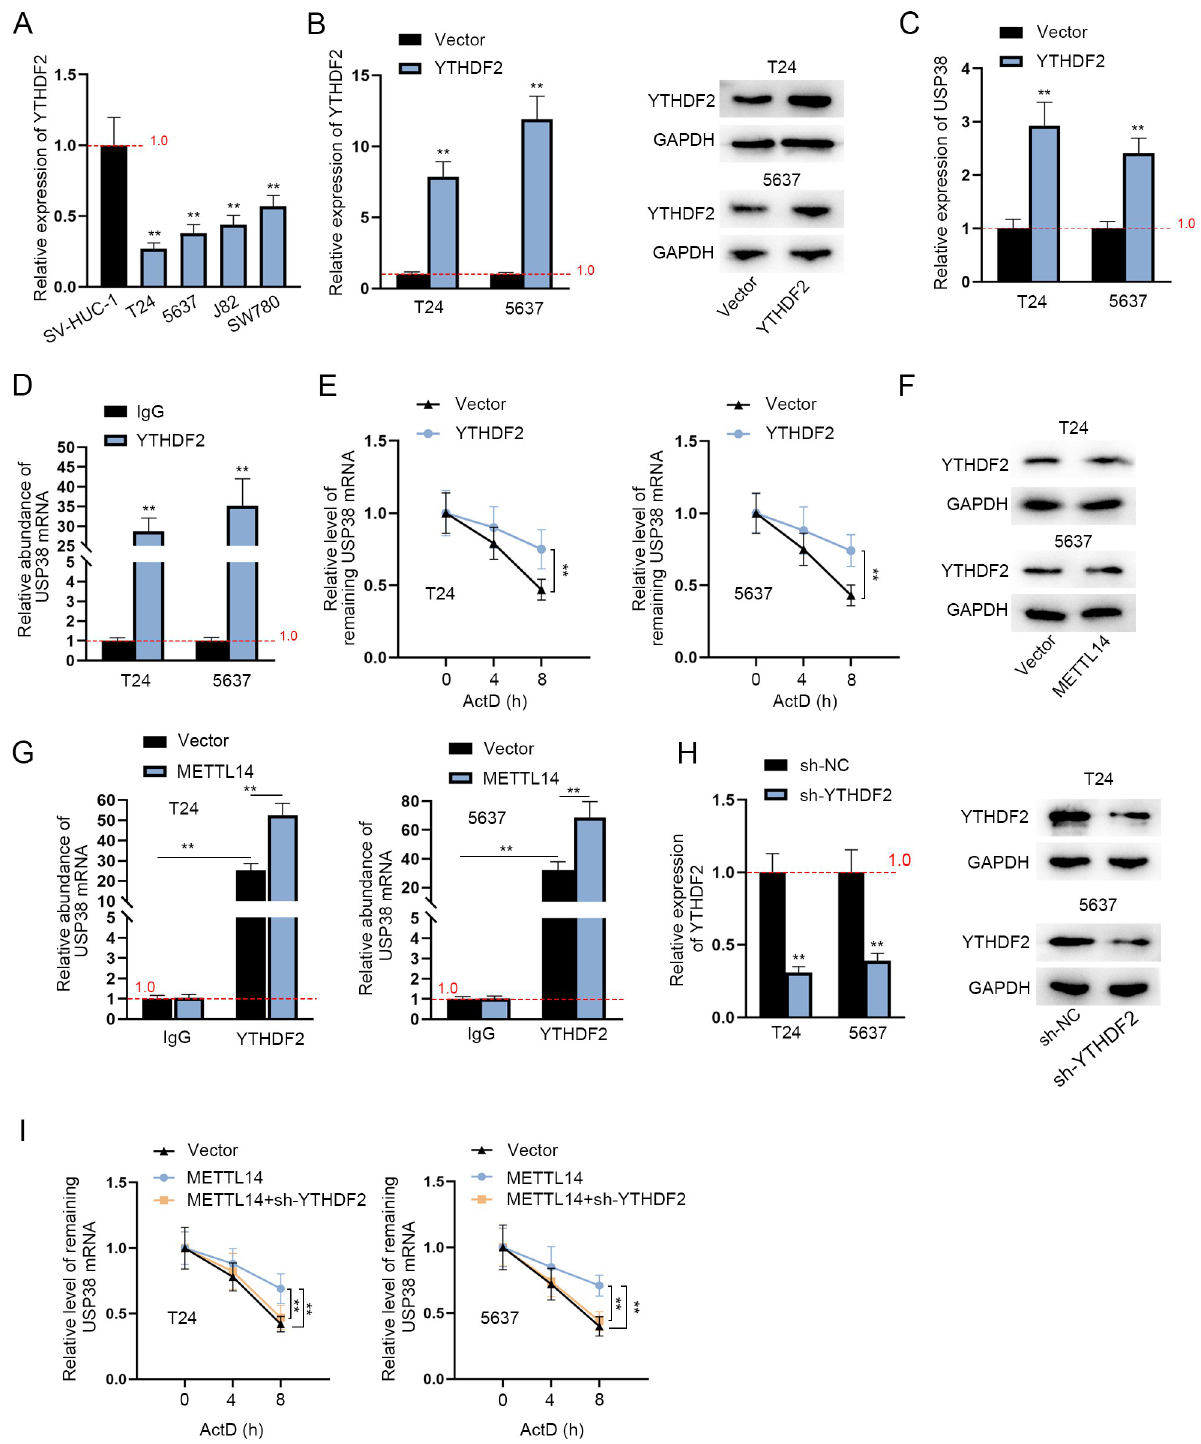
Fig 3. METTL14 enhances the stability of USP38 mRNA via YTHDF2. A. The relative expression of YTHDF2 in human normal uroepithelium cell line (SV-HUC-1) and BCa cell lines (T24, 5637, J82 and SW780) was evaluated by RT-qPCR. (n = 3) Each bar represents mean; error bars represent SD. P values were determined by one-way ANOVA followed by Dunnett’s test. B. The overexpression efficiency of pcDNA3.1-YTHDF2 was verified through RT-qPCR (left panel). (n = 3) Each bar represents mean; error bars represent SD. P values were determined by Student’s t test. Western blot of YTHDF2 protein level was shown (right panels). C. RT-qPCR was conducted to assess the relative expression of USP38 before and after the overexpression of YTHDF2 in BCa cells. (n = 3) Each bar represents mean; error bars represent SD. P values were determined by Student’s t test. D.